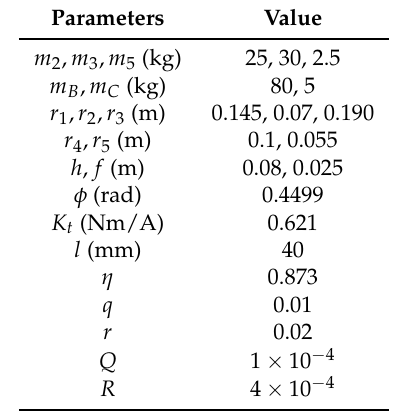
Table 1. Parameters of the TM , SS , and EKF in the experiment.